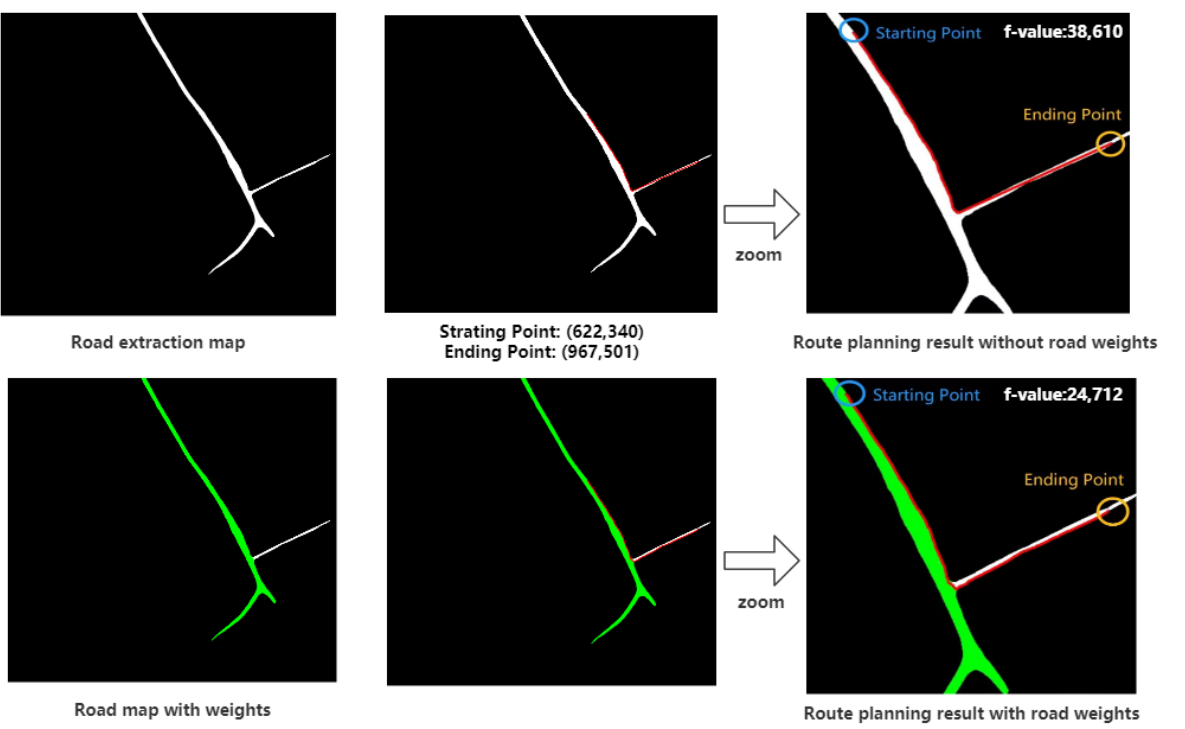
Figure 8. Optimal route planning results for the road maps with and without weight assignment in the UAV dataset.